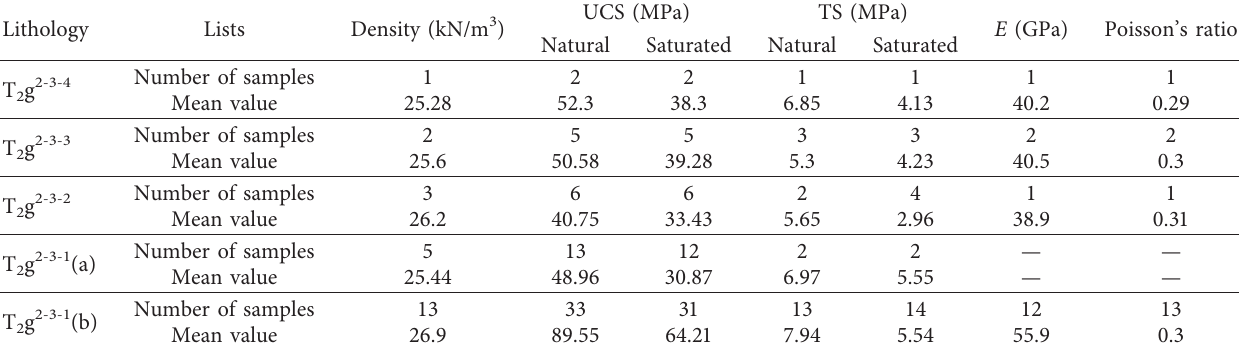
Poisson’s ratio